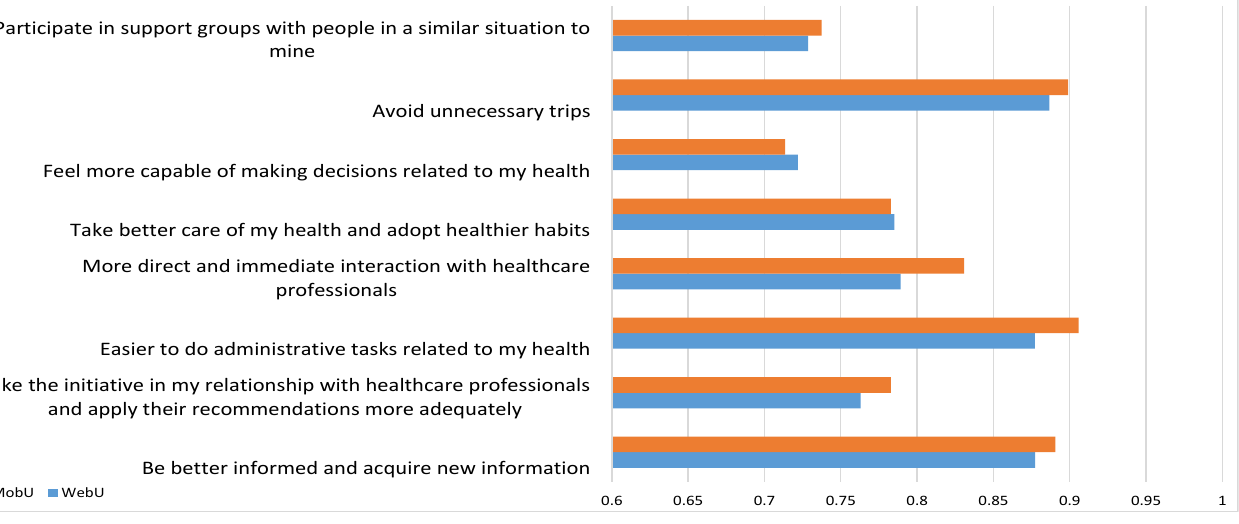
Table 4. Importance of measures to foster access to eHealth (by user profile).